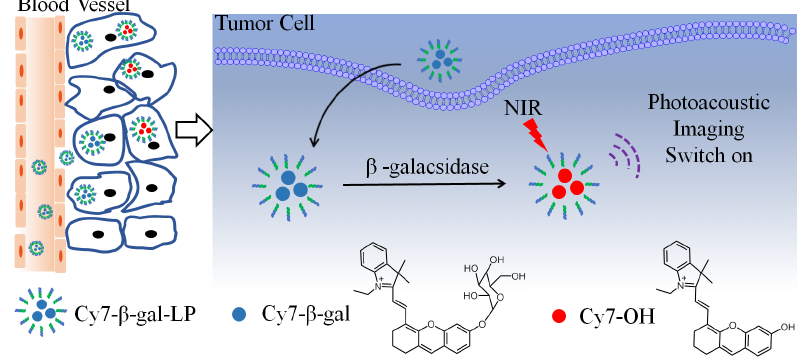
Fig. 1. Illustration of the mechanism for PA detection of (cid:1)